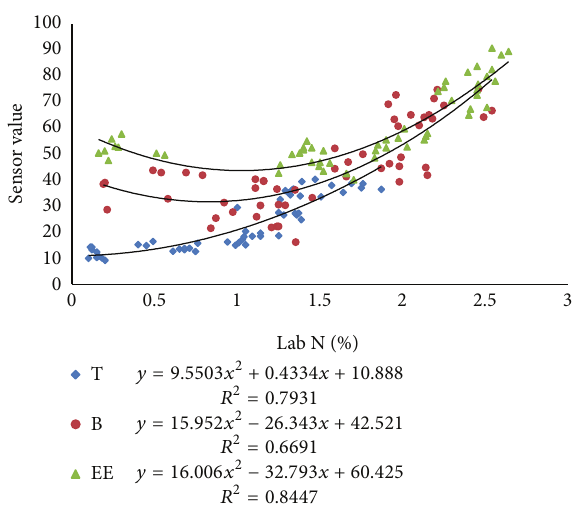
Figure 11: Correlations between sensor values (SN) and Lab N at different crop growth stages.